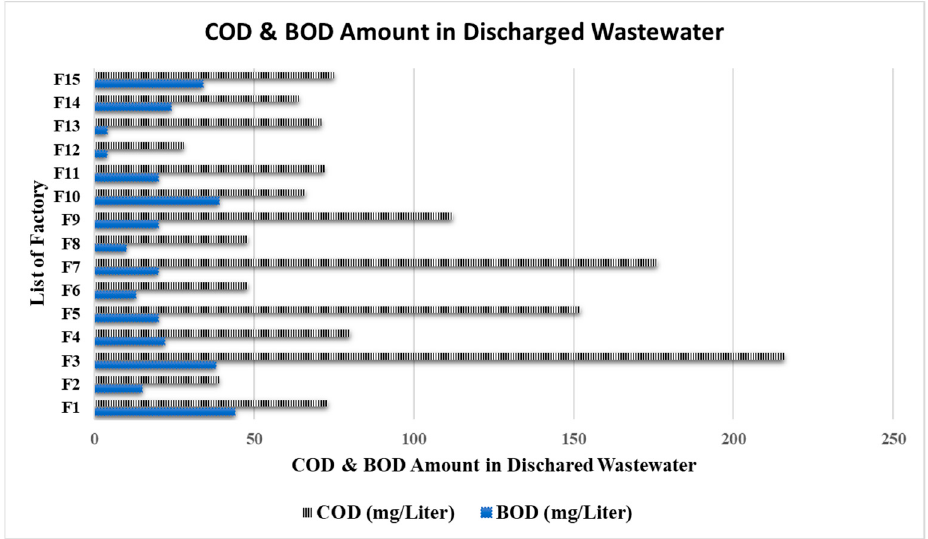
Figure 8. COD & BOD amount in effluent discharged wastewater.